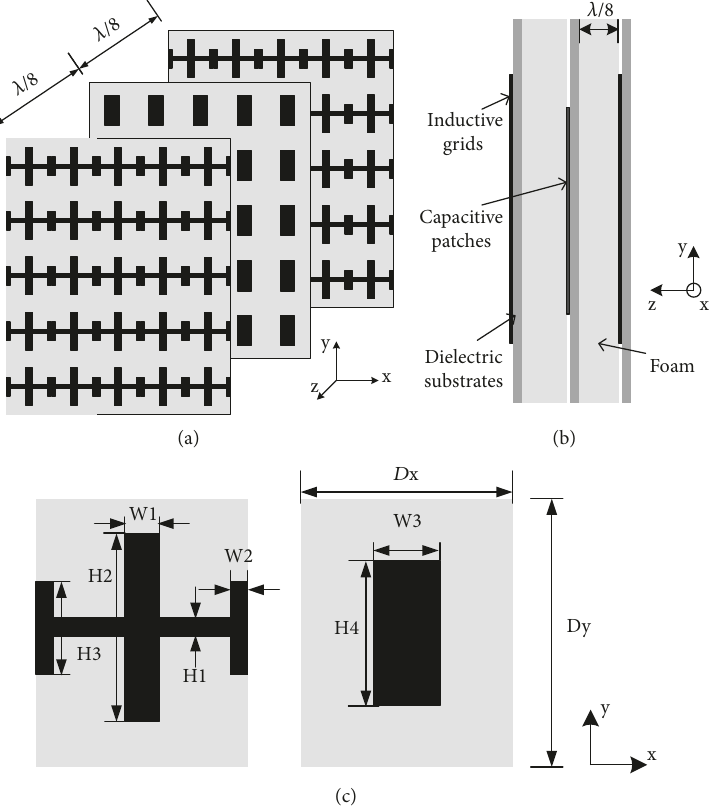
Figure 1: (a) The three-dimension (3D) topology of the proposed FSS. (b) The side view of the unit cell. (c) Unit cells of grid and patch surfaces with the de fi nitions of their dimensions (see Table 1).